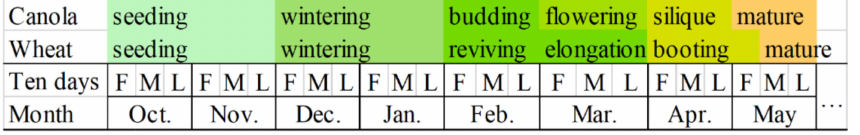
Figure 2. Phenological calendar of canola and winter wheat. F, M, and L represent the first, middle, and last 10 d of a month,